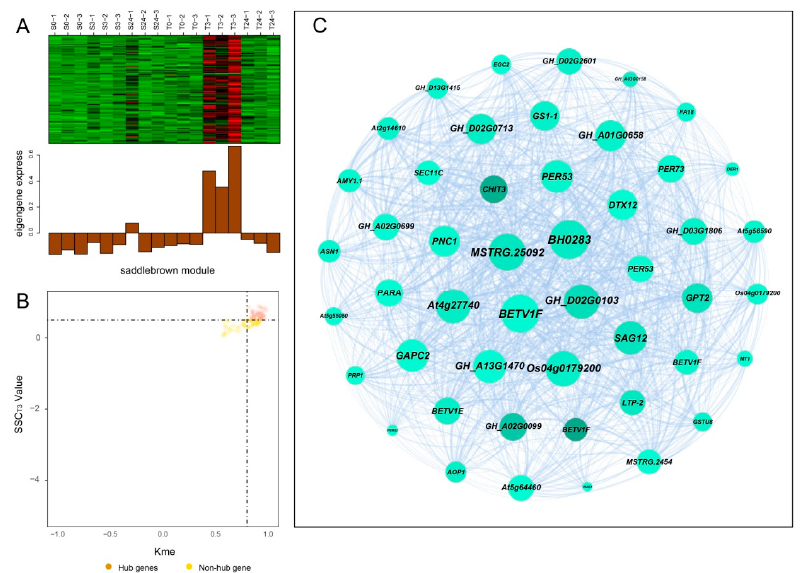
reflects the weight value.